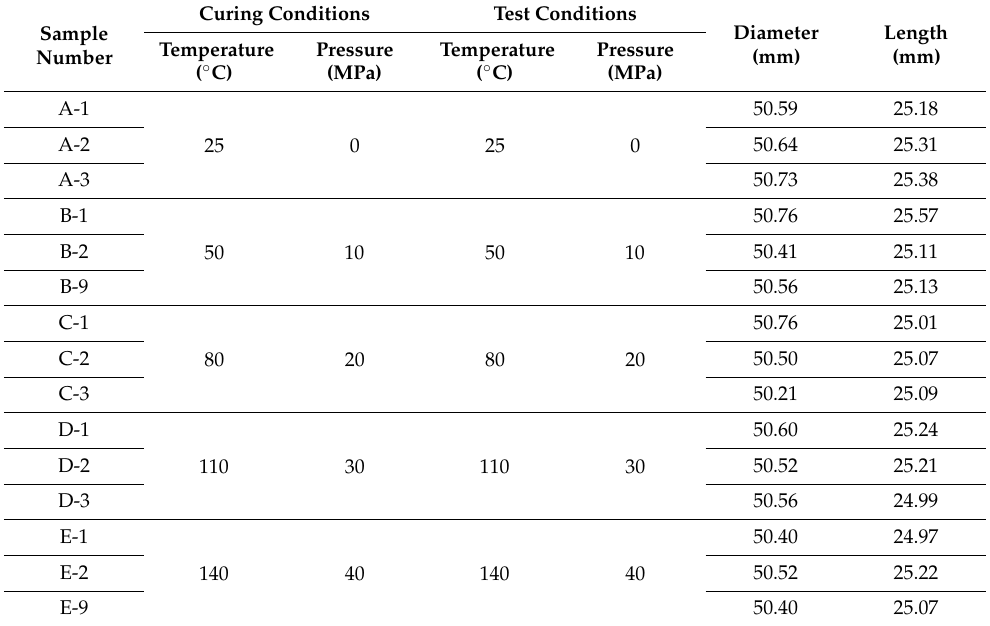
Table 2. Physical parameters of cement stone.